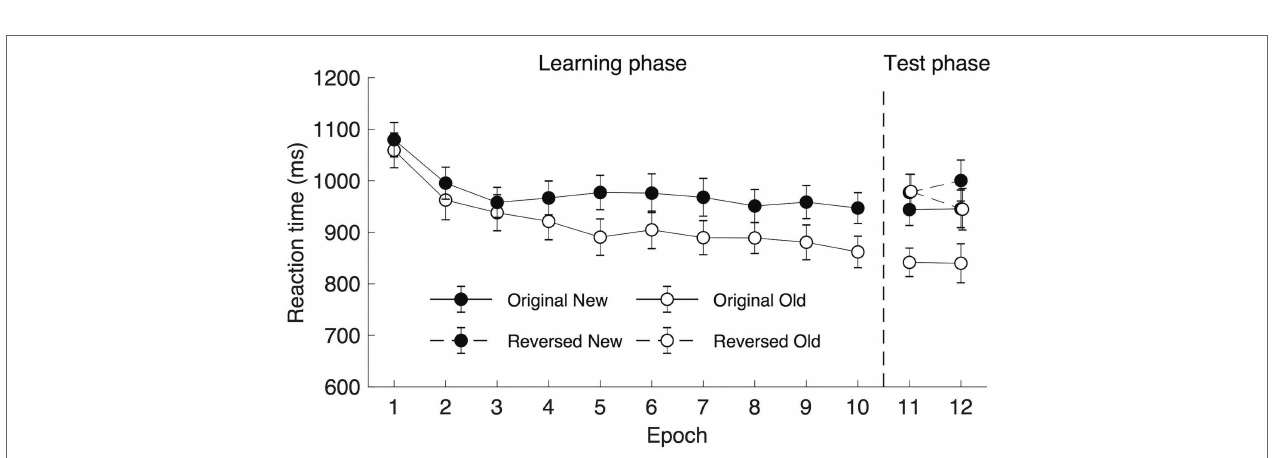
FIGURE 4 | Mean error rates in the learning (epoch 1–10) and the transfer (epoch 11–12) phases as a function of epoch, context, and display type under long (2,500 ms) search display presentation. The error bars represent the within-subject SE of the mean. The black circle lines indicate the new context and the open circle lines indicate the old context. The solid line indicates the original context and the dashed line represents the reversed